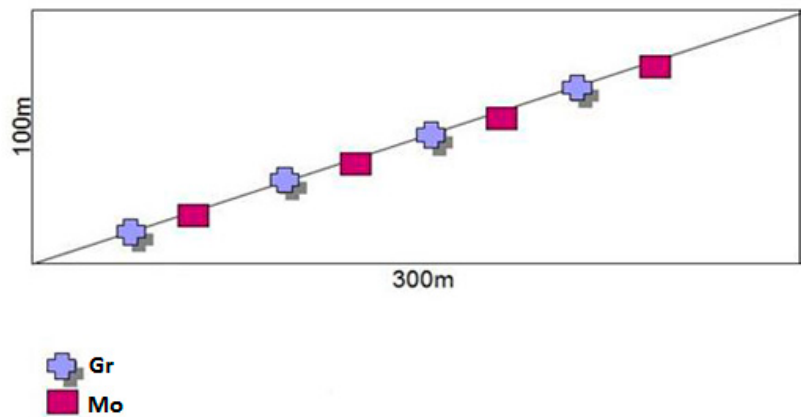
Figure 2. Localization of research areas for soil and microbiome characteristics determination. Legend: Gr–grazing system, Mo–mowing system.